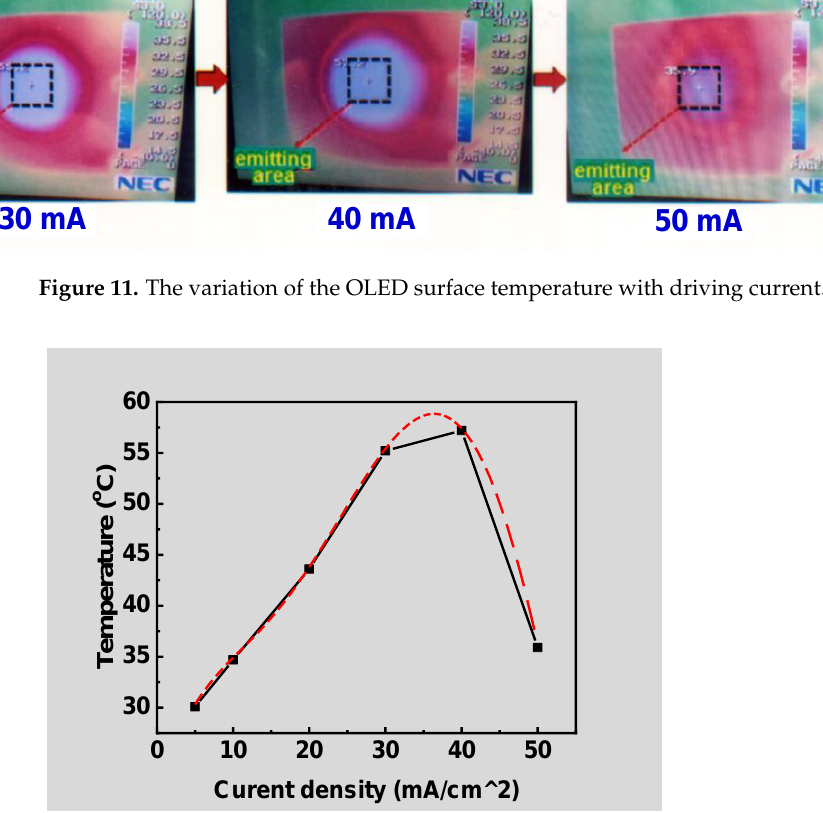
Figure 12. Relationship between OLED surface temperature and current density, where square dots are measured data and red dashed curve is numerical fitting.